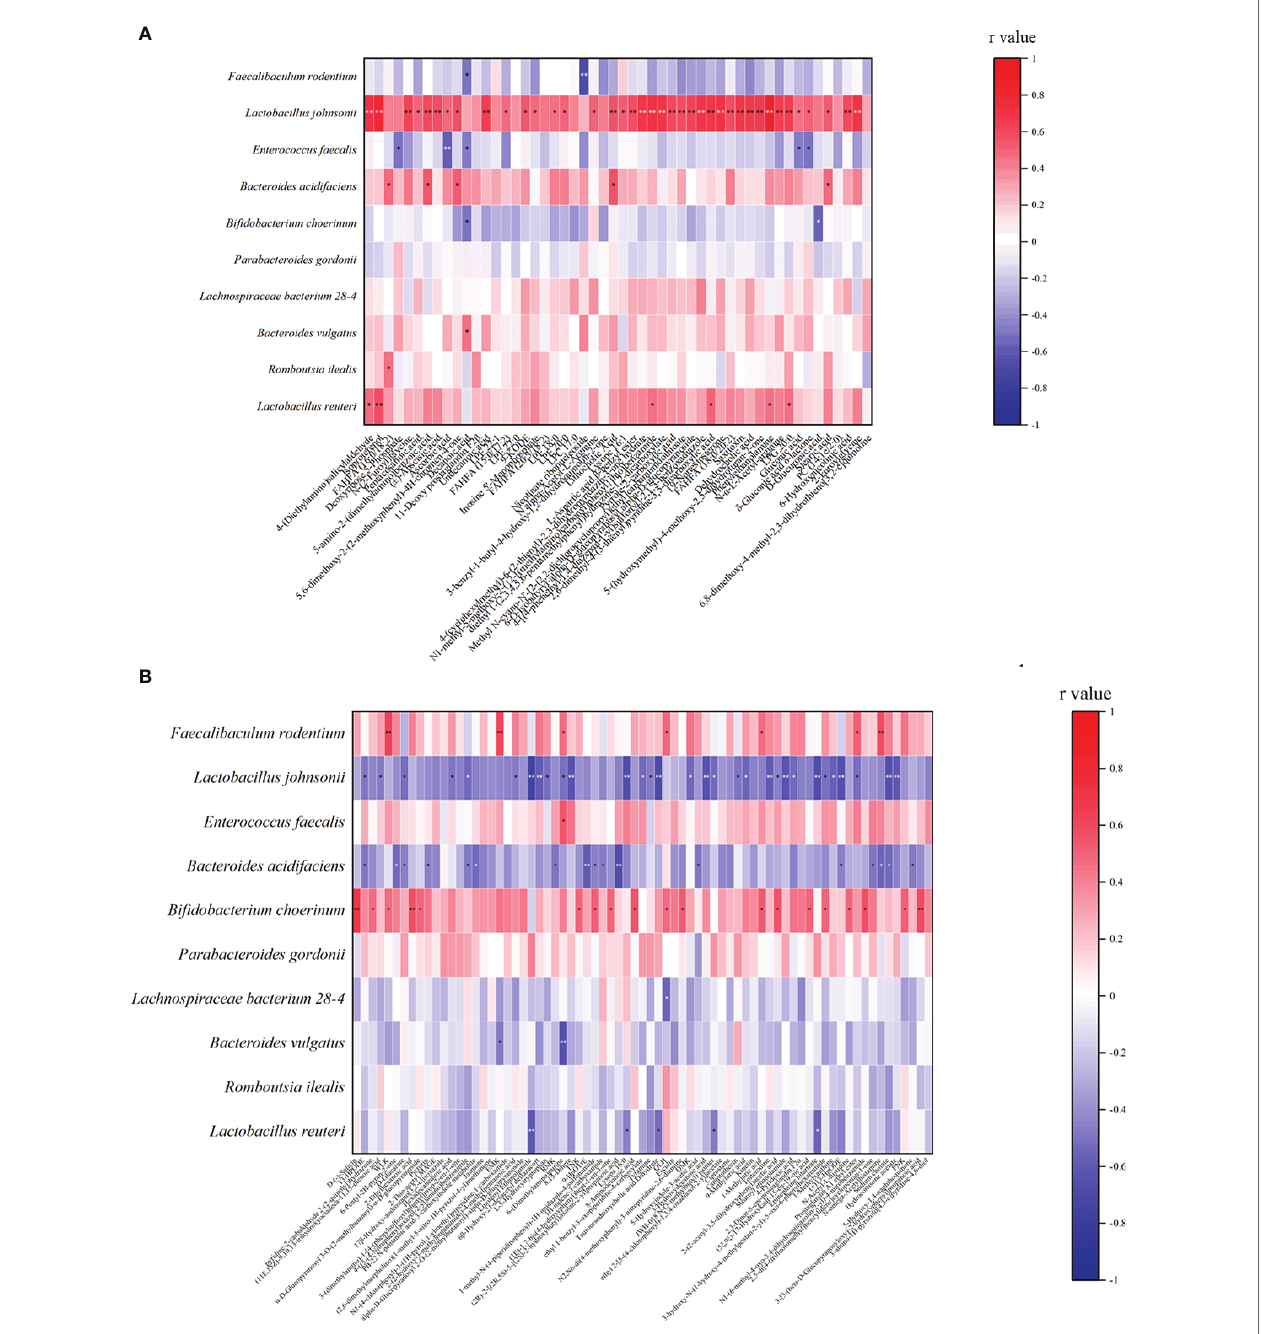
FIGURE 4 | Spearman correlation analysis between the most signi fi cant difference ( p< 0.01) metabolites and the top 10 microbial species with the highest abundance. (A) The most signi fi cant increased metabolites ( p< 0.01) and the top 10 microbial species with the highest abundance between AO and CIS groups; (B) the most signi fi cant decreased metabolites ( p< 0.01) with the top 10 microbial species with the highest abundance between AO and CIS groups. * p < 0.05, ** p <